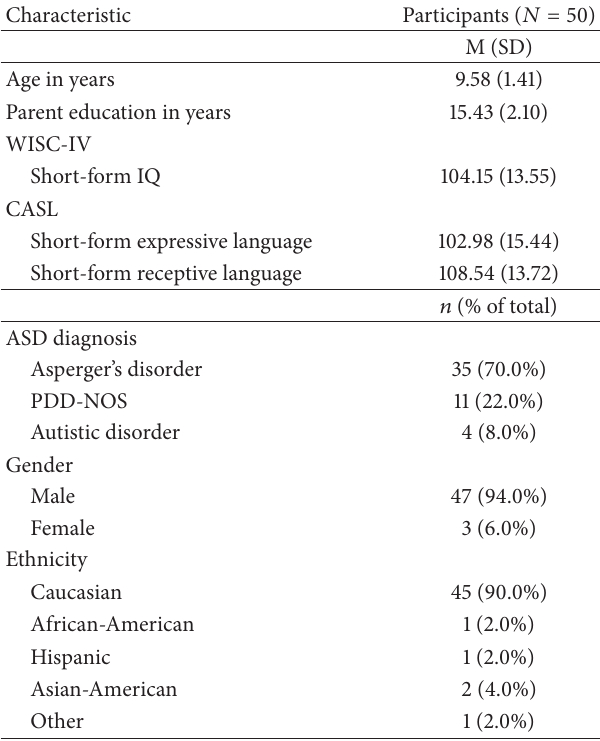
Table 1: Sample demographic